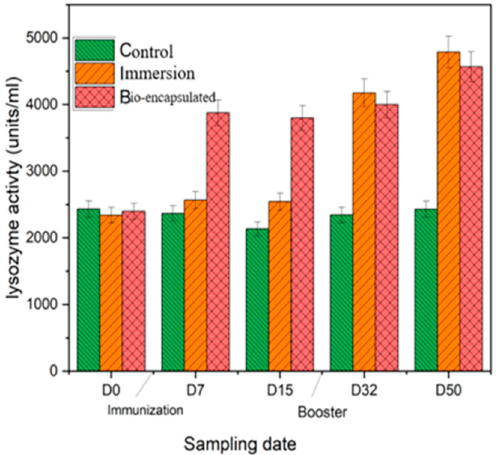
Figure 5. Serum lysozyme activity of the juvenile Cyprinus carpio L. in all three groups, control, bio-encapsulated and immersion at day 0, 7, 15, 32 and 50.